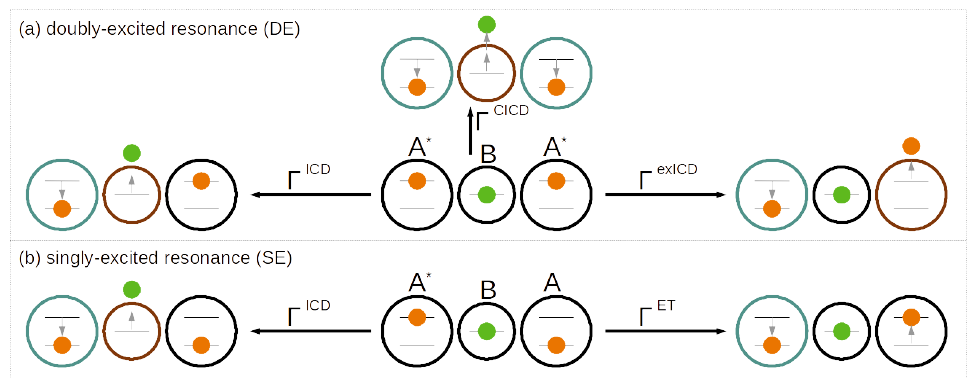
Figure 1. Overview of decay processes of up to three electrons on three Coulomb-coupled sites ABA in linear arrangement. The decaying ( a ) doubly excited (DE) and ( b ) singly excited resonances are shown in the center of each panel. To the left in ( a ) and ( b ) the standard inter-Coulombic decay (ICD) among two sites is shown with relaxation (turquoise) of the electron of site A (orange) and ionization (brown) of the electron from B (green). To the right, the coupled energy-transfer (ET) among the two sites A (orange electrons) is depicted, resulting in an excited-state ICD (exICD) for the DE resonance ( a ) and a Förster-like transfer for the SE resonance ( b ) not leading to ionization. In the DE case, a collective ICD (CICD) through two-photon transfer from relaxation of both A (turquoise) can lead to ionization of the central site B (brown) as shown along the upward direction.